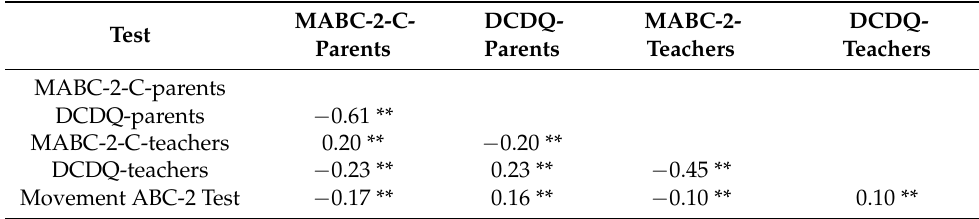
Table 5. Pearson Correlations for Movement ABC-2 Test, and Movement ABC-2 Checklist and DCDQ scores completed by parents and teachers on all children ( n = 1276).